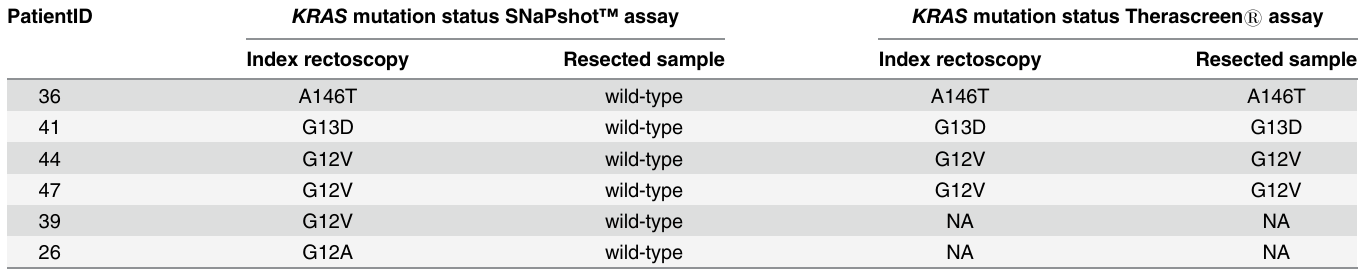
Table 2. Determination of KRAS status in samples with discrepancy between samples from index rectoscopy and surgical resected specimen by using different assay systems (NA = not applicable).